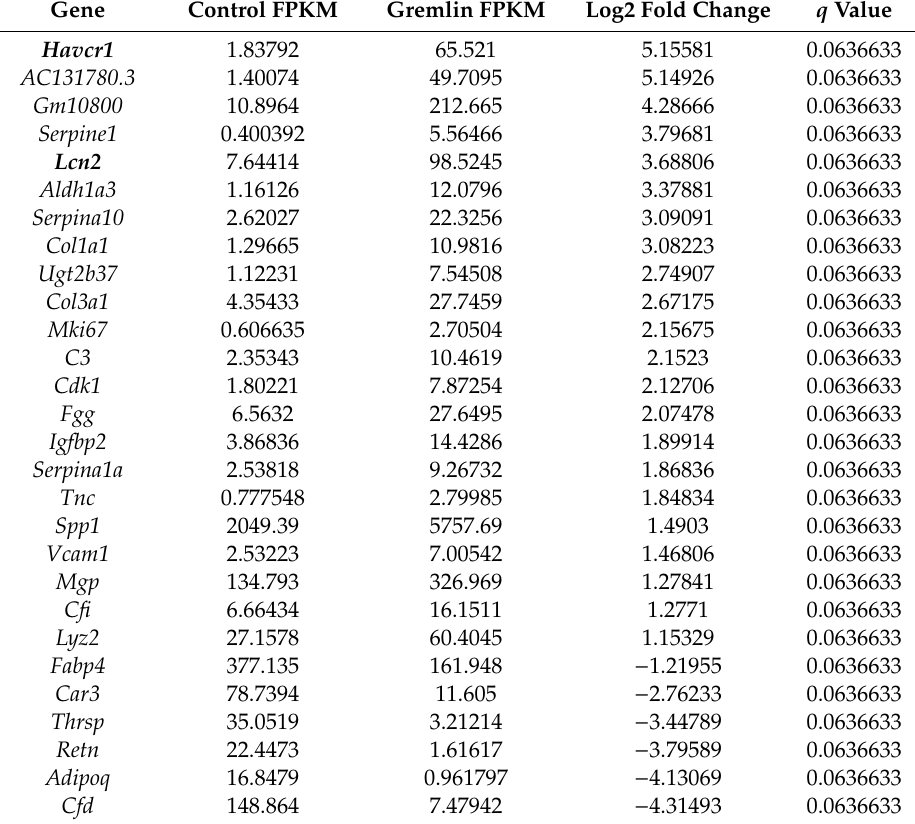
Figure 9. Heat map and unsupervised hierarchical clustering by sample and genes performed on the listed samples using the 500 genes that have the largest coefficient of variation rate based on FPKM (Fragments Per Kilobase of transcript per Million mapped reads) counts. Data is based on pool samples from the Control and Gremlin groups. Data were normalized using FPKM (abundance) for each gene for each sample. Table 2. Genes regulated by Gremlin in the kidney. Renal transcriptomic changes were evaluated by RNA sequencing comparing kidneys of control and Gremlin-treated mice. Samples from 5 samples per group were pooled and analyzed as described in Methods. The Table shows genes with > 2.5-fold upregulation in Gremlin vs. control mice. Gene Control FPKM Gremlin FPKM Log2 Fold Change q